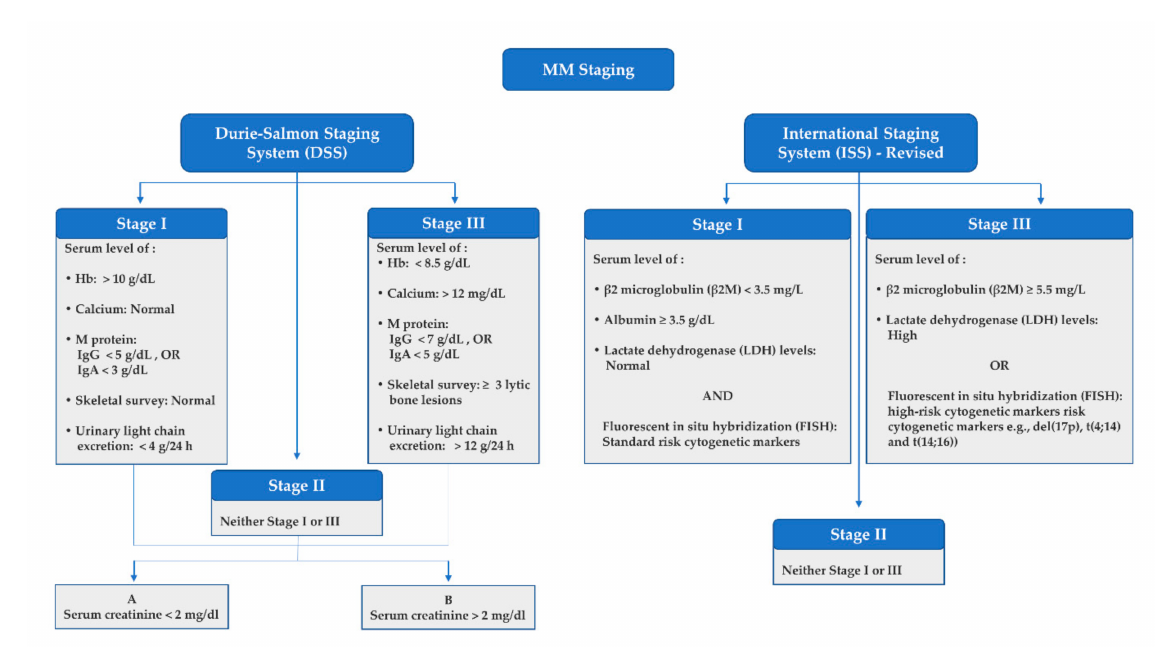
Figure 3. Multiple myeloma staging systems: Durie-Salmon PLUS System (DSS) and revised International Staging System